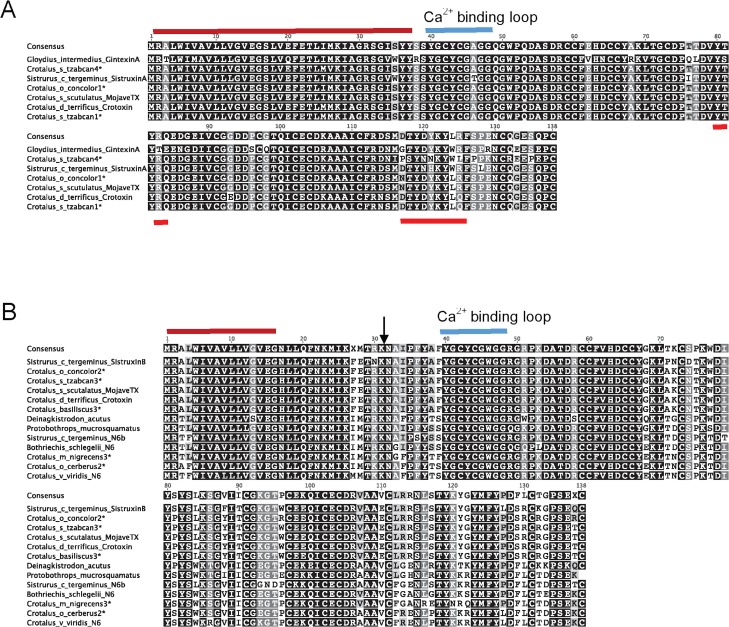
Aligned Group IIA phospholipase A2 acidic (A) and basic (B) subunit isoforms. The neurotoxic, heterodimeric PLA2 complex of crotoxin/Mojave toxin homologs consists of both an acidic A subunit and basic B subunit. A) Sequence alignments of the acidic (A) subunit of crotoxin or Mojave toxin homologs with identical residues shaded; the conserved signal peptide region is indicated by the red bar, and the Ca2+ binding loop is indicated by the blue bar. Regions of the A subunit which are post-translationally cleaved in the mature protein are indicated by red brackets below sequences. Sequences similar to crotoxin/Mojave toxin acidic subunit A derived from from venom (asterisks) were discovered in Crotalus oreganus concolor and C. simus tzabcan venoms. GenBank accession numbers of known toxins are as follows: Crotalus_s_scutulatus_MojaveTX (U01026.1), Crotalus_d_terrificus_CrotoxinA (X12606.1), Sistrurus_c_tergeminus_SistruxinA (Q6EAN6.1), and Gloydius_intermedius_GintexinA (AID56658.1). B) Sequence alignments of the basic (B) subunit of crotoxin/Mojave toxin homologs with identical residues shaded; the conserved signal peptide region is indicated by the red bar, and the Ca2+ binding loop is indicated by the blue bar. The asparagine-6 (N6) associated with neurotoxic PLA2 functionality is indicated by arrowheads. Sequences similar to the crotoxin or Mojave toxin basic B subunits derived from venom (asterisks) were discovered in Crotalus oreganus concolor, C. simus tzabcan, and C. basiliscus venoms, with N6 sequences also found in C. m. nigrescens and C. o. cerberus venoms. GenBank accession numbers of known toxins are as follows: Crotalus_s_scutulatus_MojaveTX (U01027.1), Crotalus_d_terrificus_CrotoxinB (X12603.1), Crotalus_v_viridis_N6 (AF403138.1), Sistrurus_c_tergeminus_N6 (AY355169.1), Sistrurus_c_tergeminus_SistruxinB (Q6EER2.1), Bothriechis_schlegelii_N6 (AY355168.1), Protobothrops_mucrosquamatus (AF408409.1), and Deinagkistrodon_acutus (X77649.1).